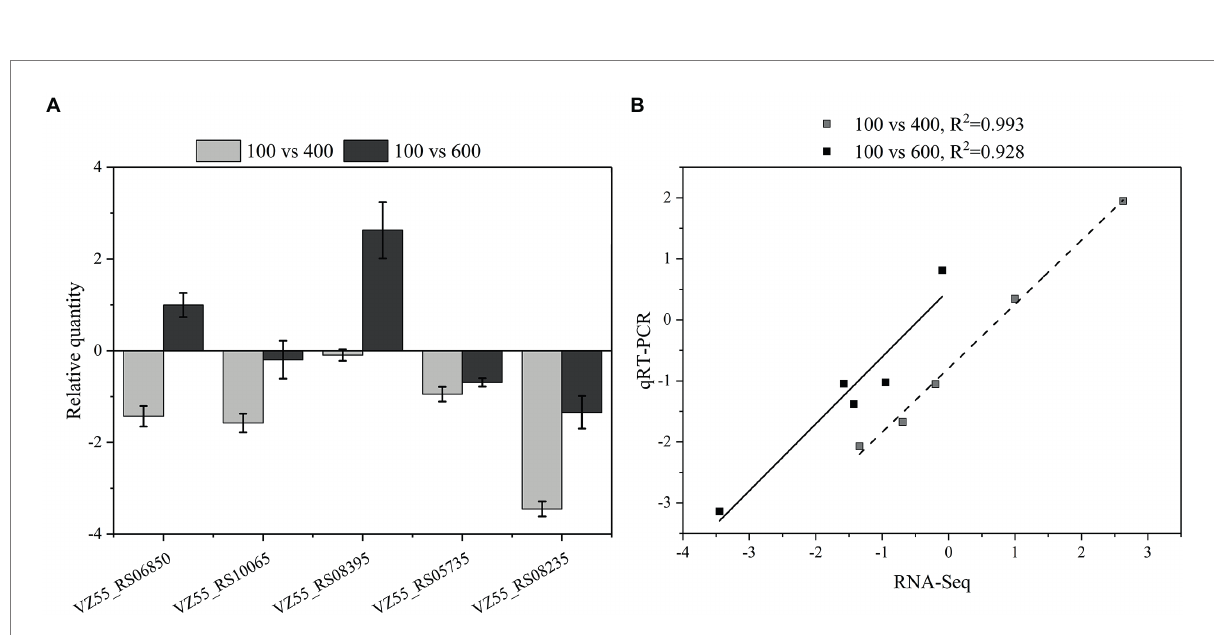
FIGURE 9 Compared transcription levels of genes of interest by qPCR and RNA-Seq. (A) Gene expression levels in qPCR. (B) Comparison of gene expression level between qPCR and RNA-Seq. A parallel experiment was conducted in